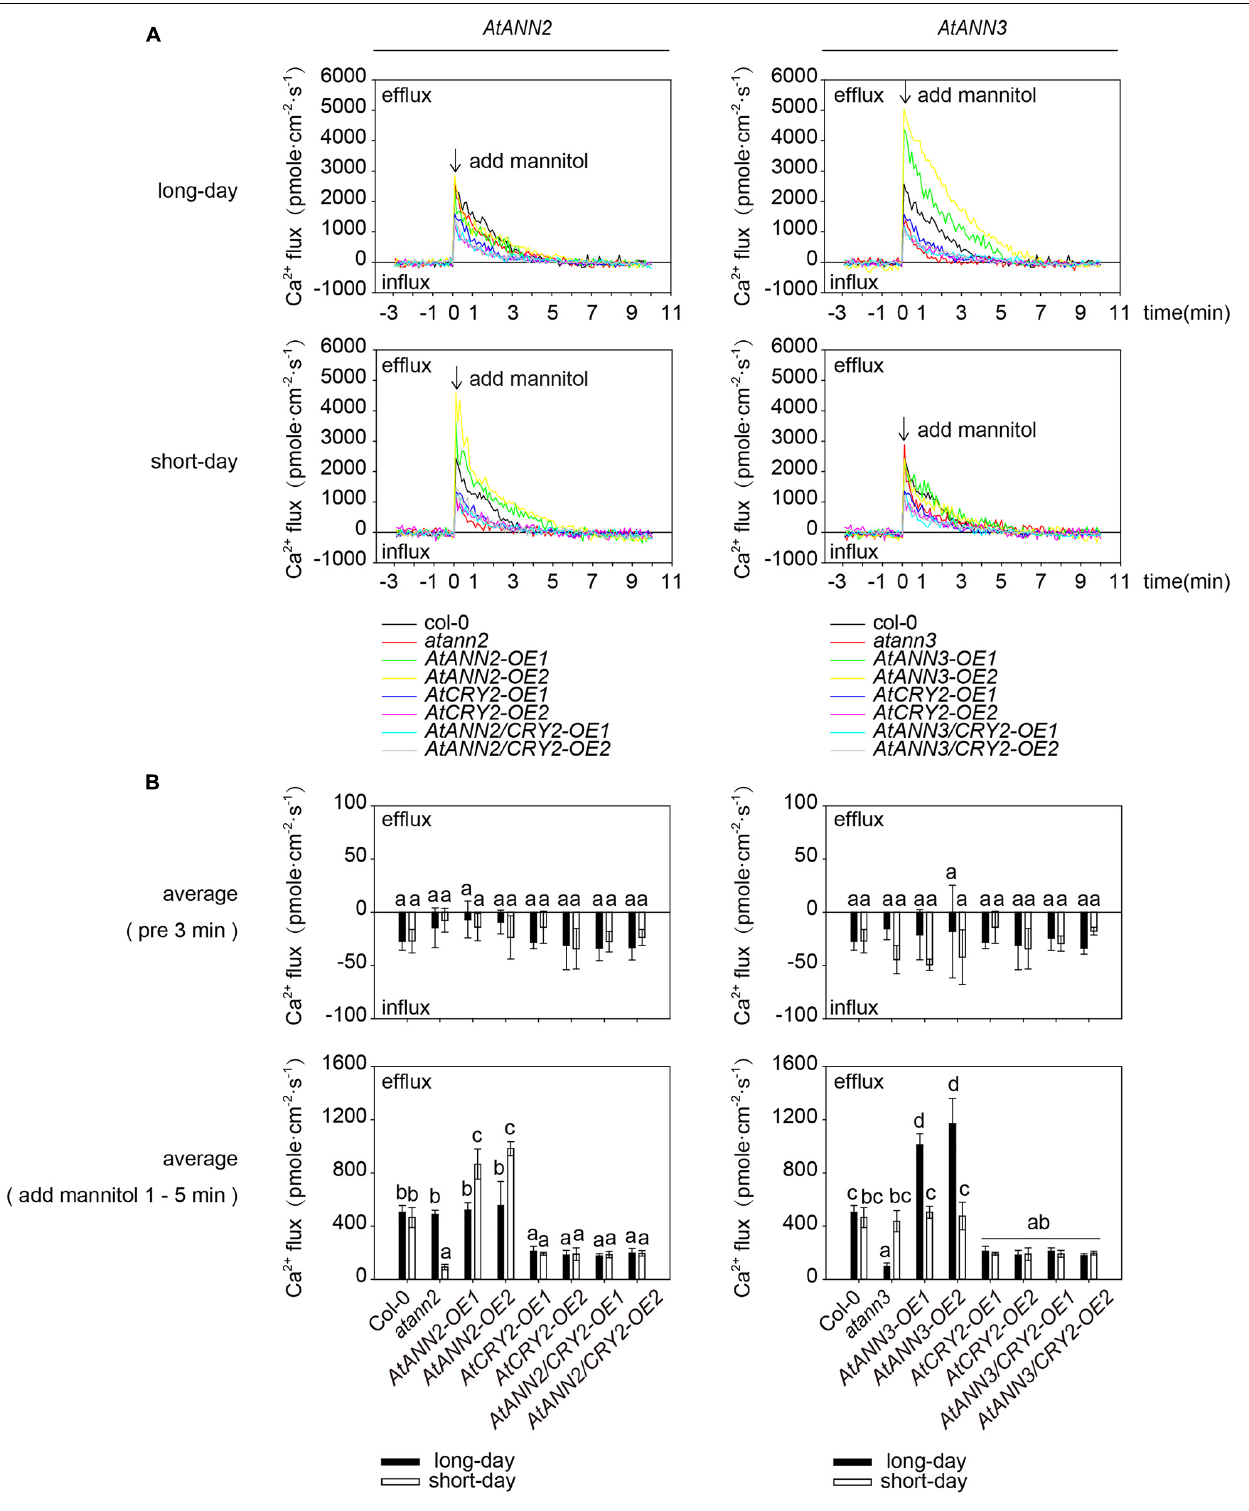
FIGURE 10 | AtCRY2 inhibited AtANN2- and AtANN3-dependent transmembrane Ca 2 + flow. (A) Transmembrane Ca 2 + flow analysis in transgenic lines overexpressing AtANN2 and AtANN3 either in the Col-0 ( AtANN2-OE and AtANN3-OE ) or the CRY2-OE background ( AtANN2/CRY2-OE and AtANN3/CRY2-OE ) subjected to treatment the same as Figure 5C . (B) Mean Ca 2 + flux values from 1 to 5 min after 300 mM mannitol treatment and control (pre 3 min) ( n = 5) in Figure 10A . Different letters indicate significant differences with each treatment at p <0.05 level.